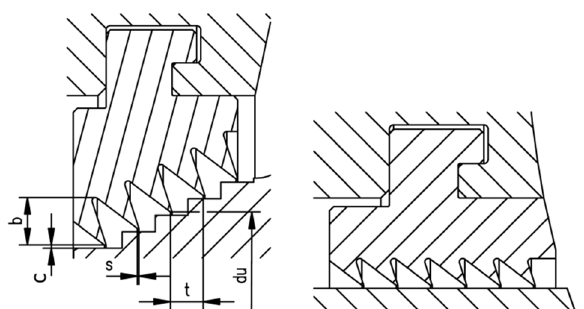
Fig. 9. The labyrinth seals for a radial compressor stage